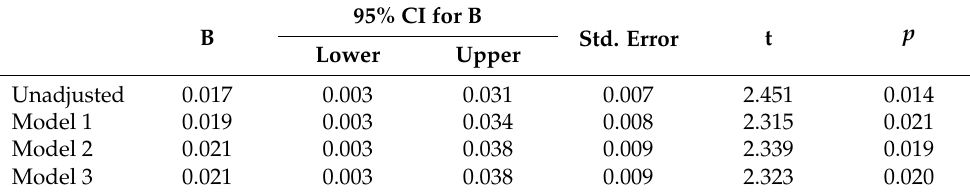
Table 2. Multivariable linear regression analysis of PP and ∆